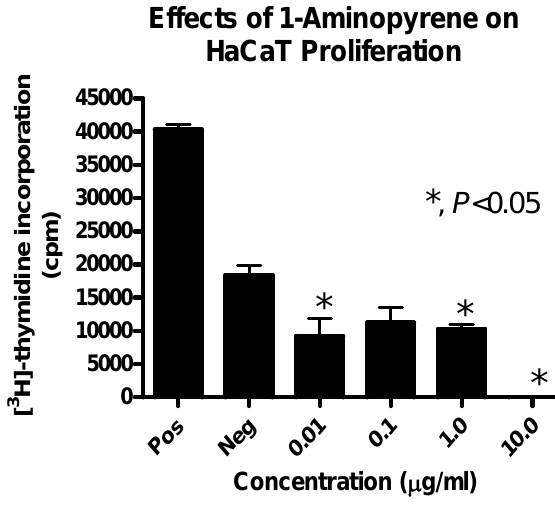
Figure 4: Effects of 1-aminopyrene on HaCaT proliferation. HaCaT cells were grown in 35mm plates to subconfluent in CGM. Cells were serum starved for 24 hours and then treated with pyrene at 0.01, 0.1, 1.0 and 10.0 μ g/ml concentrations for 18 hours. Thymidine incorporation assay was then performed as described in materials and methods. Results represent the mean +/- SD values of experiment performed in triplicate. [* indicates that treatment mean is significantly different from negative control according to Dunett test ( p<0.05